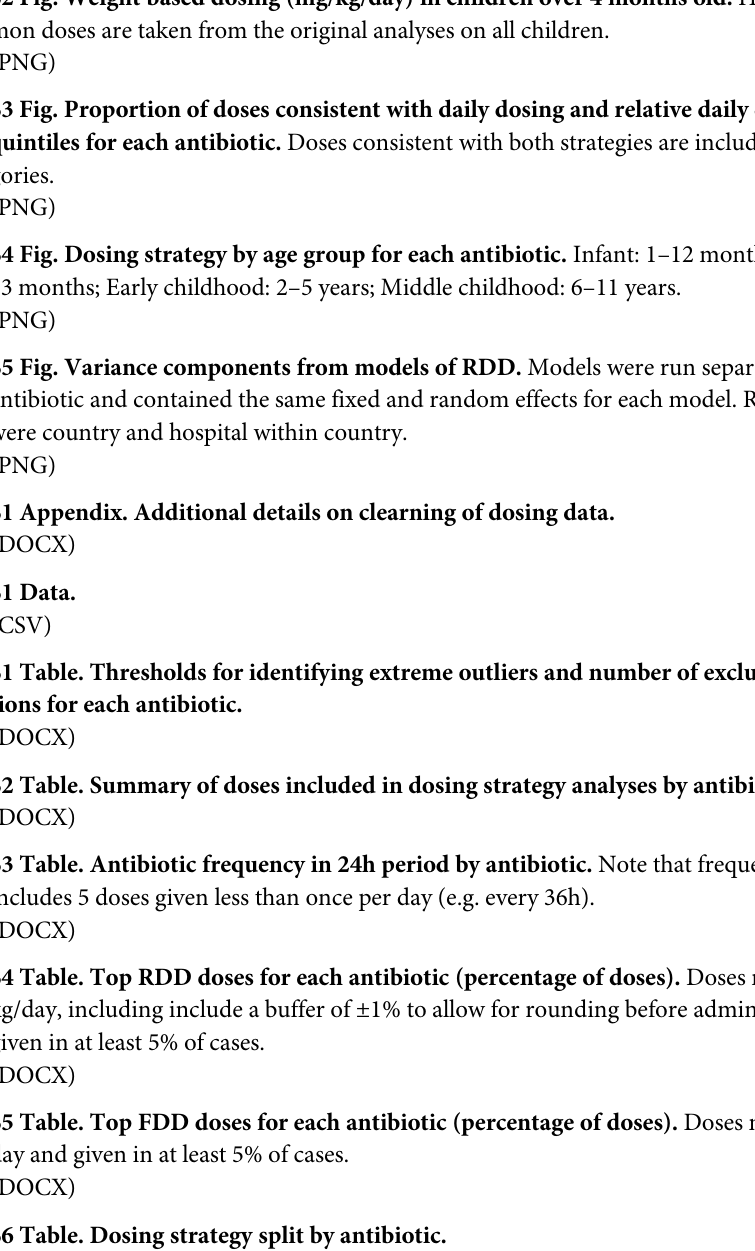
S1 Fig. Daily frequency of antibiotic dosing in children over four months. S2 Fig. Weight based dosing (mg/kg/day) in children over 4 months old. Highlighted com- mon doses are taken from the original analyses on all children. S3 Fig. Proportion of doses consistent with daily dosing and relative daily dosing by weight quintiles for each antibiotic. Doses consistent with both strategies are included in both cate- gories. S4 Fig. Dosing strategy by age group for each antibiotic. Infant: 1–12 months; Toddler 13– 23 months; Early childhood: 2–5 years; Middle childhood: 6–11 years. S5 Fig. Variance components from models of RDD. Models were run separately for each antibiotic and contained the same fixed and random effects for each model. Random effects were country and hospital within country.